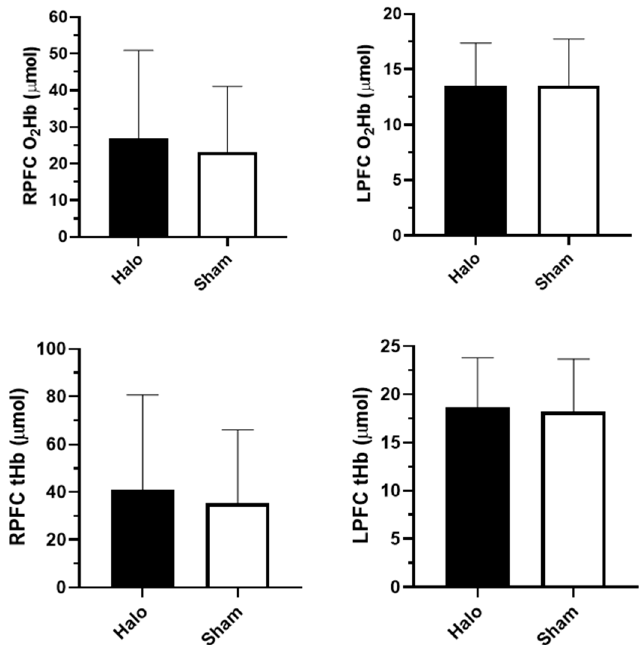
Figure 2. Brain oxygenation results.